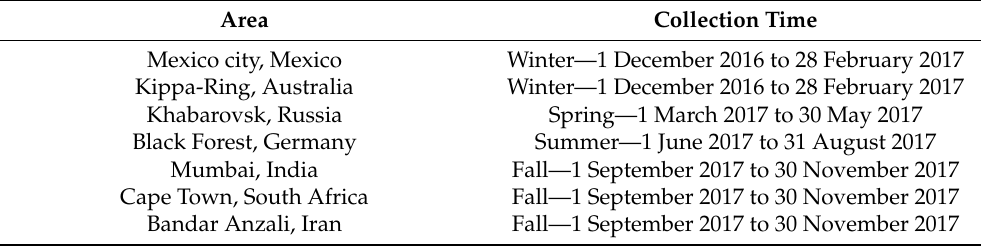
Table 3. Study area and data collection time on DFC2020.